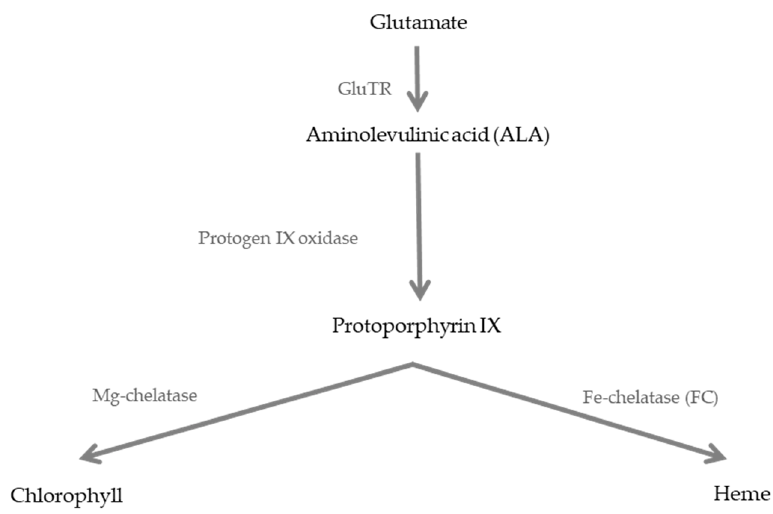
Figure 1. The tetrapyrrole biosynthesis pathway with the major end-products (bold text) and some catalytic enzymes. GluTR—glutamyl-tRNA reductase and Protogen IX oxidase—Protoporphyrinogen IX oxidase.